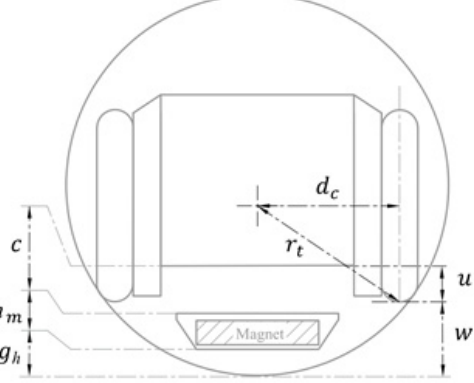
Figure 5. The parameters for the shim plate thickness calculation.